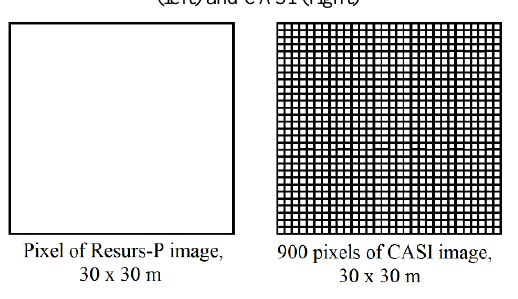
Figure 3. Relation of pixels from Resurs-P and CASI